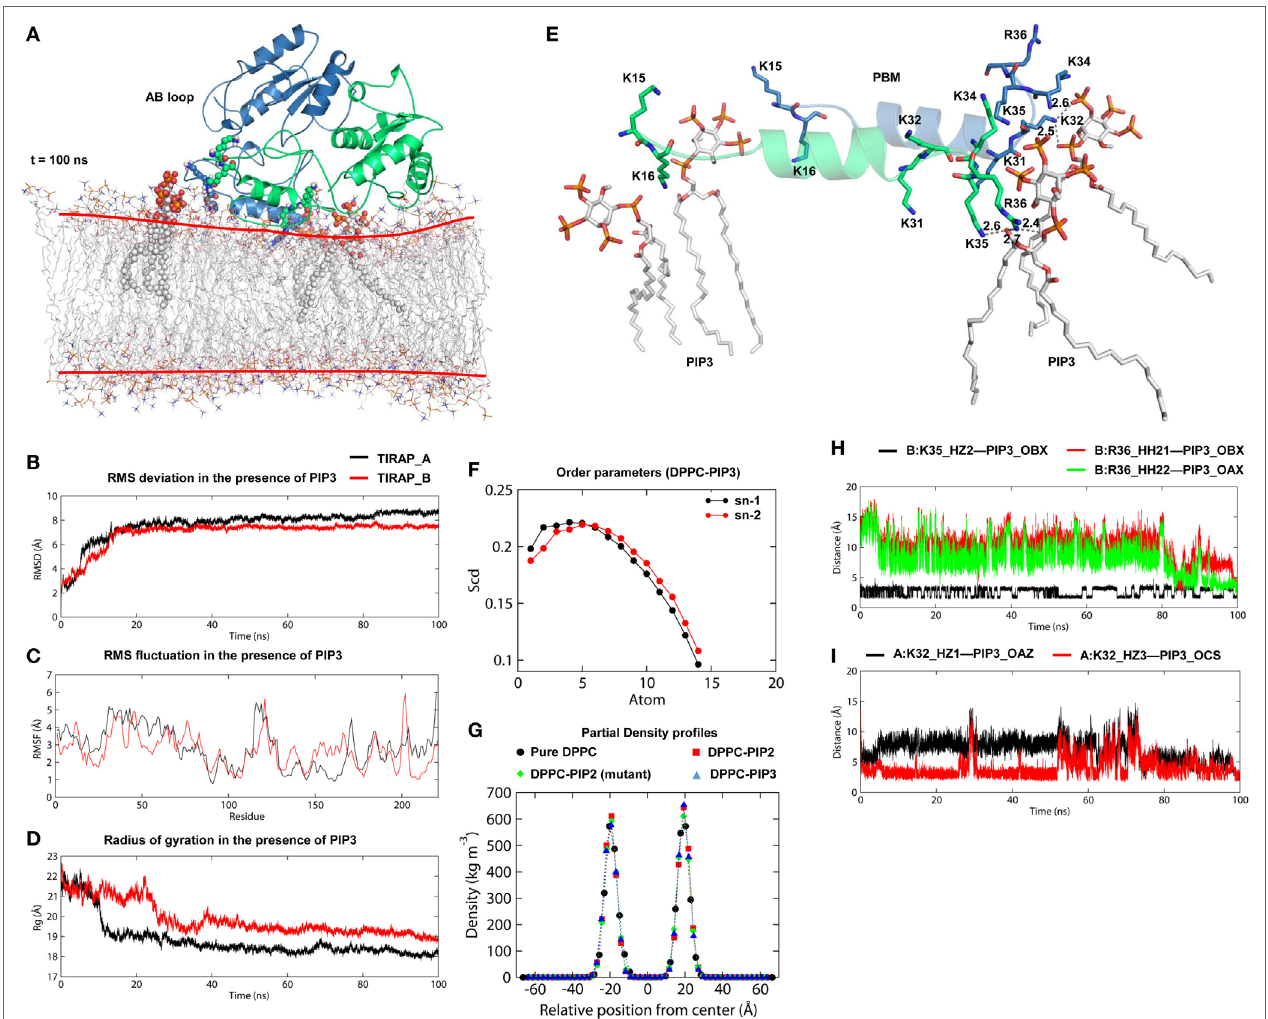
FigUre 7 | Stability and interaction properties of toll/interleukin 1 receptor domain-containing adaptor protein (TIRAP) and a dipalmitoylphosphatidylcholine (DPPC)-phosphatidylinositol (PI) (3,4,5)-trisphosphate (PIP3) bilayer. (a) Overall structure of TIRAP over a DPPC–PIP3 bilayer. TIRAP is colored blue for chain A and green for chain B. The red lines on the membrane indicate the approximate positions of DPPC headgroups. PIP3 and PI-binding residues are shown as spheres. (B) Root mean square deviation; (c) root mean square fluctuation; and (D) radius of gyration (Rg). The black and red curves represent chains A and B, respectively. (e) Interaction of PIP3 with TIRAP–PBM. Dashed lines represent hydrogen bonds, and digits indicate distances in angstrom units. (F) Order parameters for sn-1 and sn-2 chains of DPPC lipids in the presence of PIP3. (g) Headgroup density profiles of four different DPPC membranes: black: pure DPPC, red: DPPC–PI 4,5-bisphosphate (PIP2), green: DPPC–PIP2 (under mutant TIRAP), and blue: DPPC–PIP3. (h,i) Intermolecular distances between H-bond-forming atoms of K32, K35, R36, and PIP3 as a function of